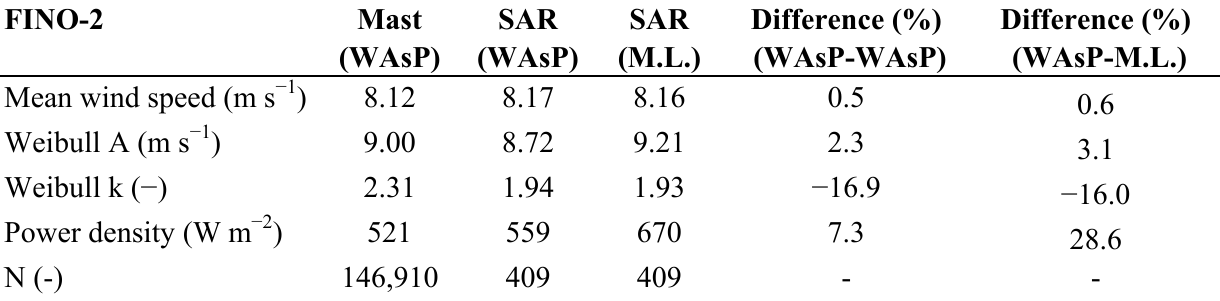
Table 5. Wind resource statistics at FINO-2 using all meteorological observations at 102 m extrapolated to 10 m using WasP. For SAR wind maps using WAsP and using maximum likelihood (M.L.) and the differences SAR normalized with mast data (in percentage).